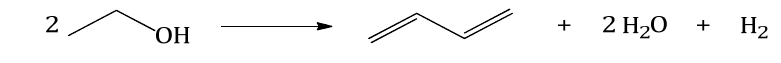
Scheme 1. Total reaction equation of the conversion of ethanol to 1,3-butadiene.